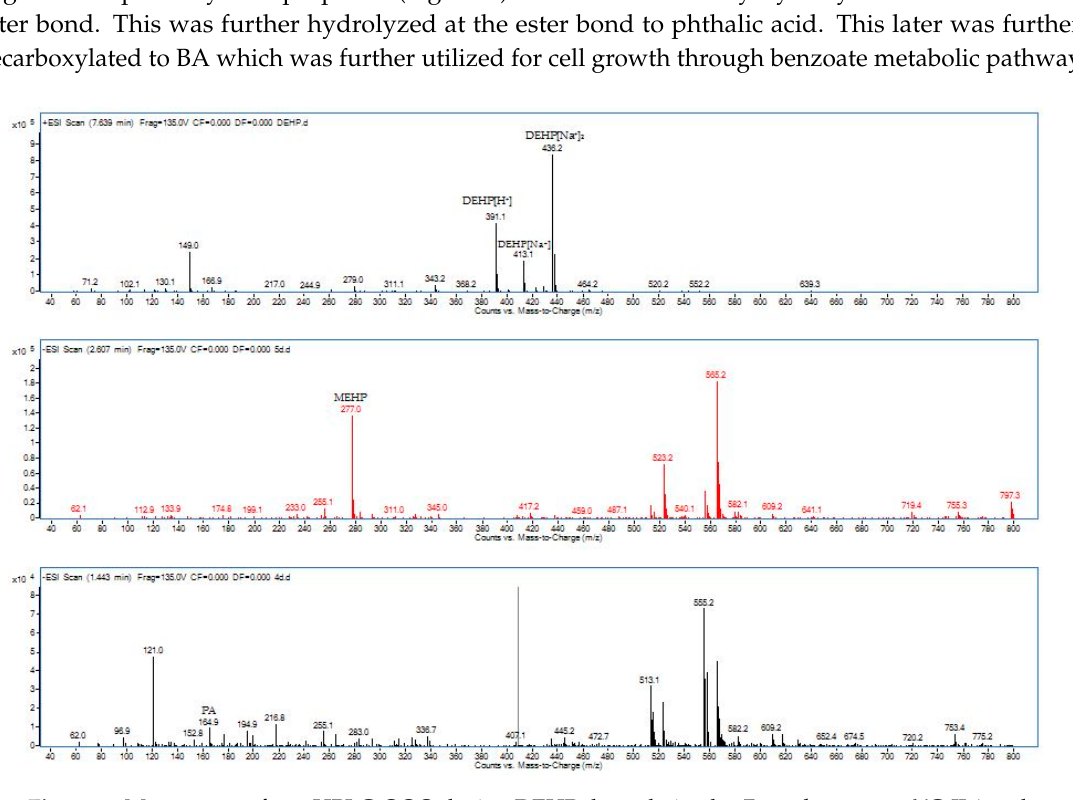
Figure 5. Mass spectra from HPLC-QQQ during DEHP degradation by Enterobacter spp . YC-IL1 and detected intermediate compounds, MEHP: mono-ethylhexyl phthalate, PA: phthalate acid.